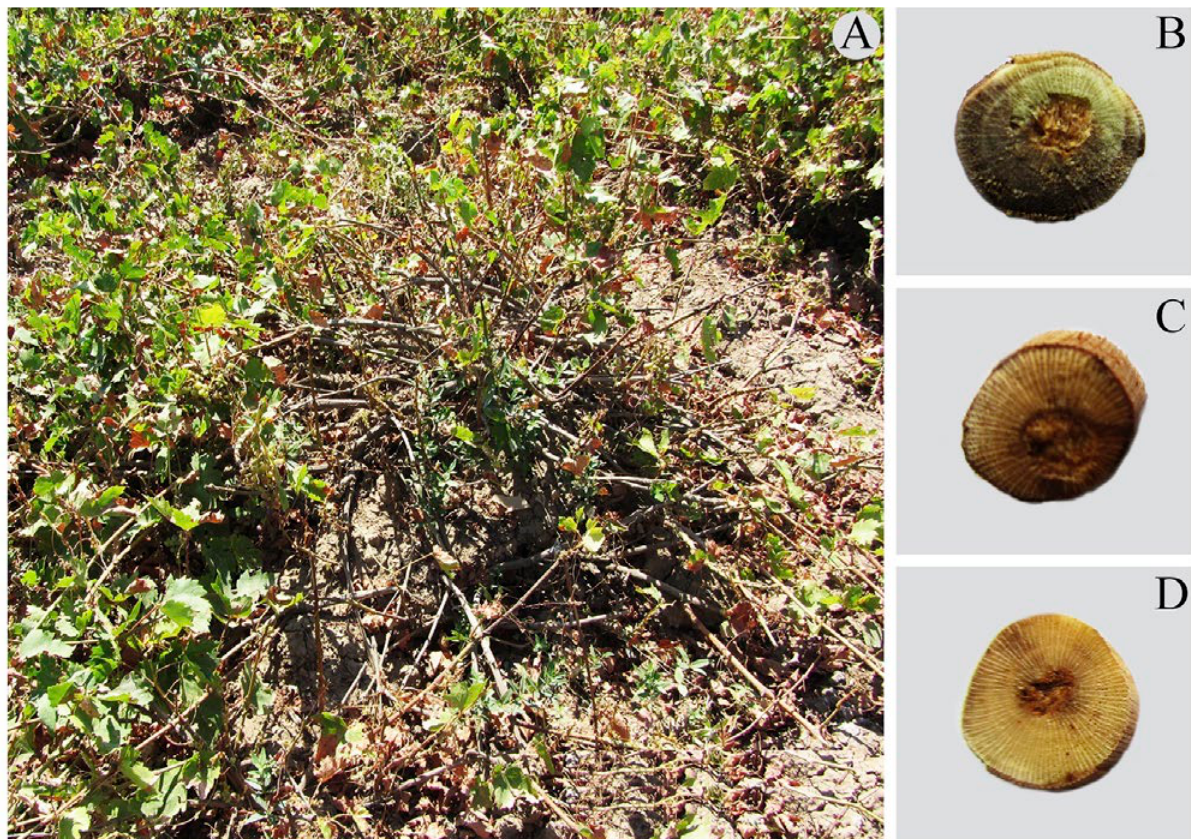
Figure 1. A. Decline symptoms on grapevines from which only Macrophomina phaseolina was isolated. B–D. Various symp - toms of wood discolouration and necrotic lesions in trunk